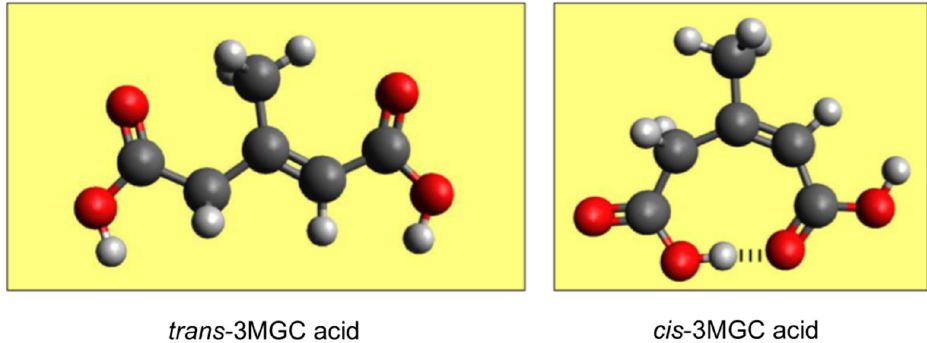
Figure 3. Model depicting enhanced stability of cis -3MGC acid versus trans -3MGC acid. Energy minimized molecular model of trans -3MGC acid and cis -3MGC acid. The potential for intramolecular hydrogen bonding between carboxylate groups in cis -3MGC acid (see dashed lines), but not trans - 3MGC acid, provides an explanation for the apparent higher stability of the cis diastereomer.